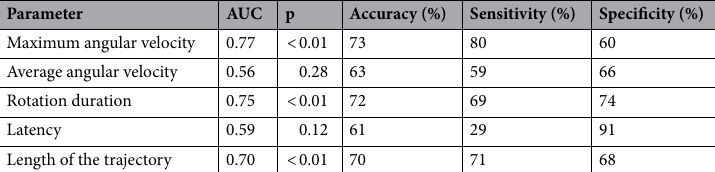
Table 2. Single-sensor model results based on ROC analysis.